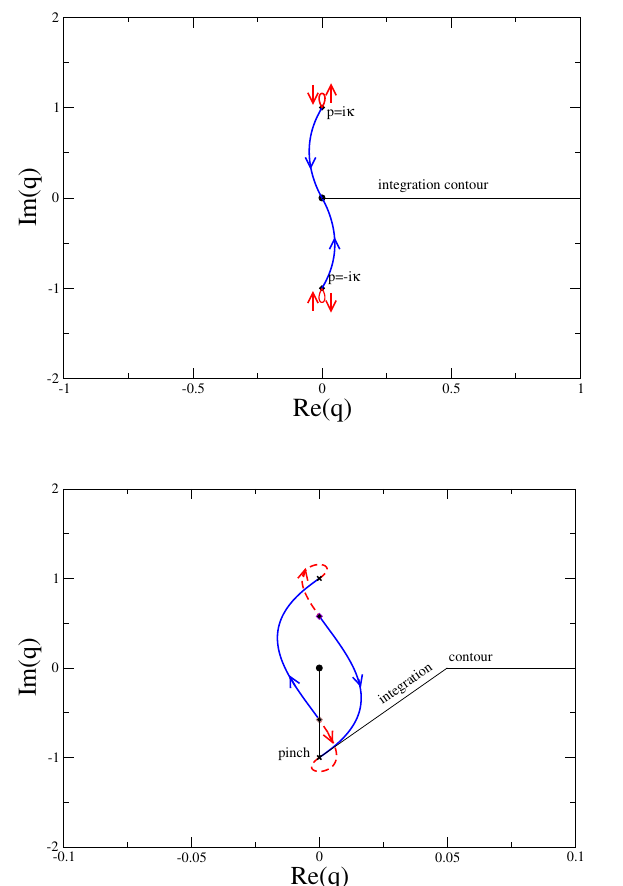
Figure 2 . Trajectories of the singularities of the kernel of eq. (3.8) in the complex q -plane, Left panel: p ! i(cid:20) , right panel: p ! 2 i p